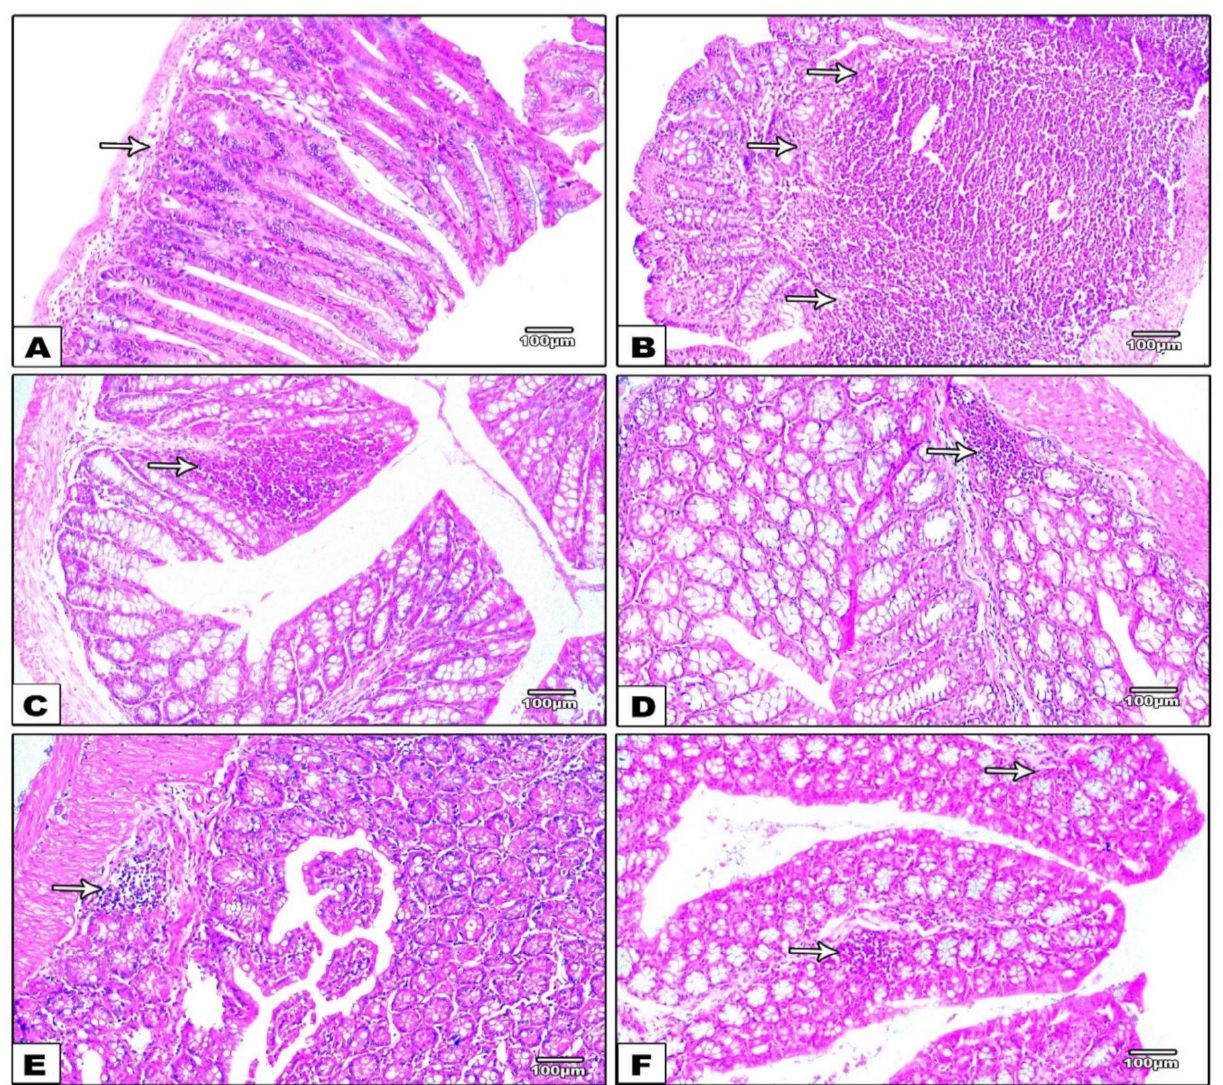
Figure 7. In the control negative group ( A ), microscopic images of H&E stained colonic sections show only a few scattered chronic inflammatory cells. Conversely, the Di-MH group ( B ) has a marked positive inflammatory infiltrate with prominent lymphoid follicles (arrows). Moderate inflammation with lymphoid aggregates in the DOX 5 mg/kg group ( C ), mild inflammation with minor aggregates in the DOX 10 mg/kg group ( D ), and few inflammatory cells in the DOX-PRNP2 5 and 10 mg group ( E , F ). Magnifications of H&E stain X100 bar 100, X400 bar 25. Figure 8 demonstrates the tumor scores given to colon specimens. Scores for cryptic distortion were greater in the colon cancer control group than in the saline group. The scores were significantly reduced in mice treated with DOX-PRNP2 5 or 10 mg/kg (Figure 8A). Scores for hyperplasia, goblet cell depletion and dysplasia were also significantly higher in the colon cancer control group compared to the saline group (Figure 8B–D); these three scores were significantly reduced in the DOX-PRNP2 10 mg/kg